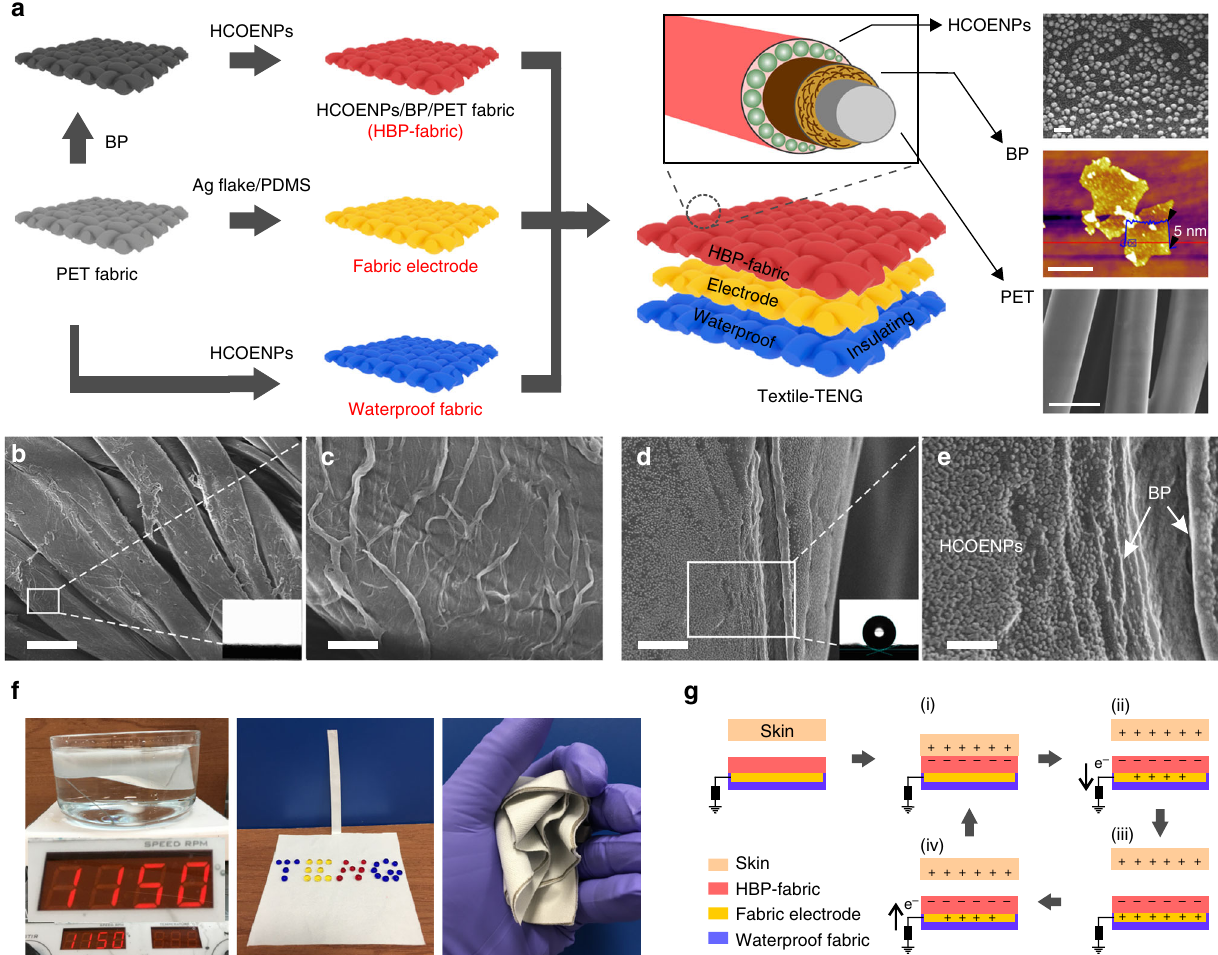
Fig. 1 Con fi guration and working mechanism of skin-touch-actuated textile triboelectric nanogenerator. a Schematic illustration of the fabrication process of textile triboelectric nanogenerator (textile-TENG) based on the polyethylene terephthalate (PET) fabrics. The charge-induced component, HCOENPs/ BP/PET fabric (HBP-fabric) was realized on a PET fabric, with successive coating of black phosphorus (BP) and hydrophobic cellulose oleoyl ester nanoparticles (HCOENPs). The fabric electrode is a PET fabric enabled by coating with a conductive paste that composed of silver fl akes and polydimethylsiloxane (Ag fl ake/PDMS). PET fabric with coating of HCOENPs layer serves as the waterproof fabric for encapsulating the fabric electrode. Scanning electron microscopy (SEM) and atomic force microscopy (AFM) images on the right side of ( a ) indicate the morphologies of three components of HBP-fabric. HCOENPs, scale bar, 100 nm. BP, scale bar, 2 µ m. PET fabric, scale bar, 20 µ m. b SEM planar top view of continuous BP coating on the PET fi bers. Scale bar, 20 µ m. c Enlarged view of the region marked with a box in b , showing the winkled BP sheet on PET fi bers. Scale bar, 2 µ m. d SEM image of a representative HBP- fi ber. Scale bar, 1 µ m. e Enlarged view of the region marked with a box in d , revealing the BP layer with dense coating of HCOENPs. Scale bar 300 nm. f Photographs demonstrating that textile-TENG is washable and deformable. g Schematic illustration of the working mechanism